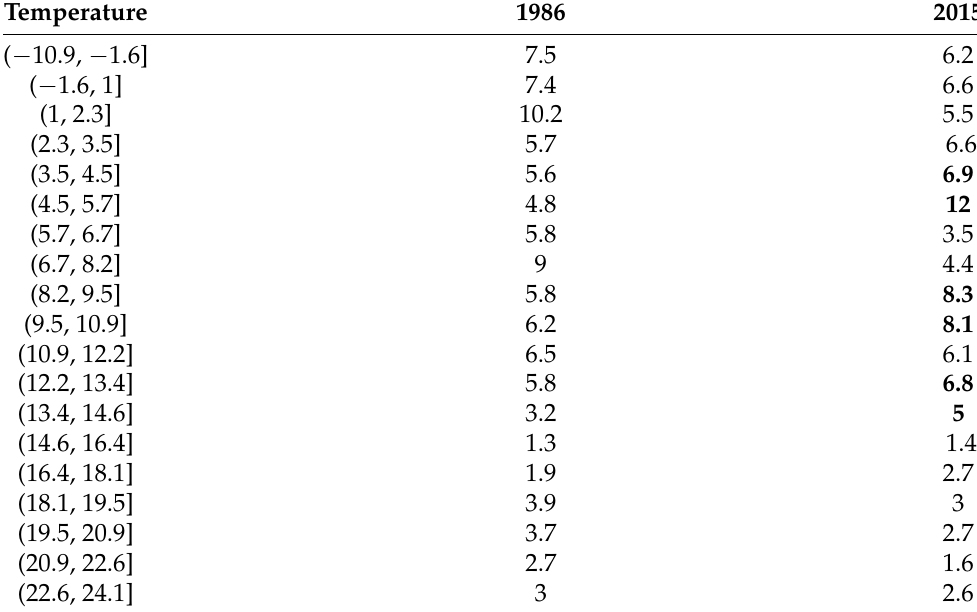
Table 3. Percentage of meteorological stations in temperature classes for Lombardy in 1986 and 2015. Those percentages of meteorological stations that are higher than 1% in 2015 with respect to 1986 are shown in